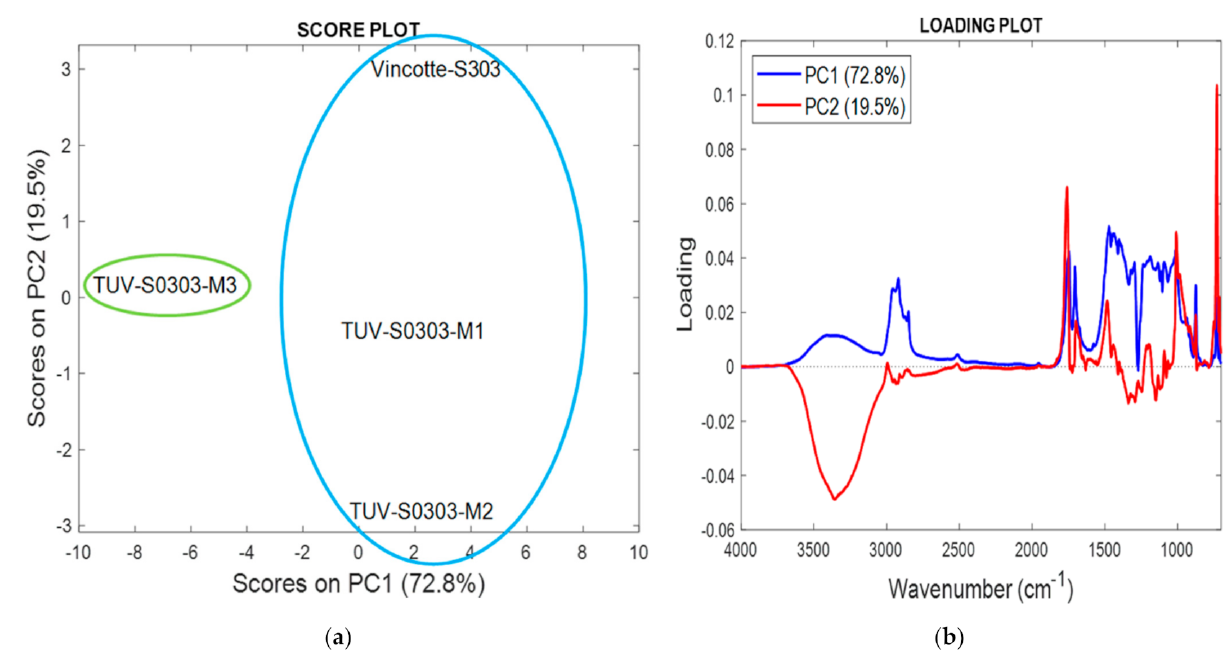
Figure 7. Results of PCA represented as score plot ( a ) and loading plot ( b ) performed on the small matrix collecting spectral data of four samples, by using R